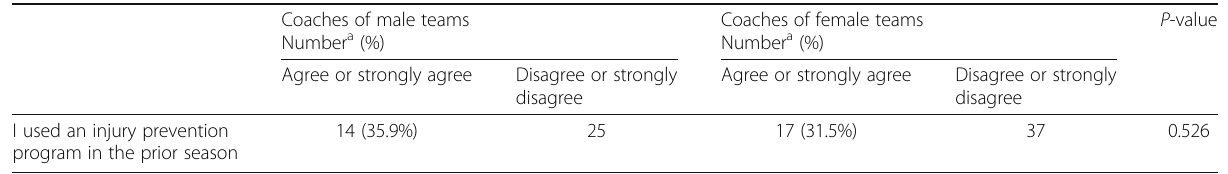
Table 3 Intervention use by coaches of male and female teams Coaches of male teams Number a (%)